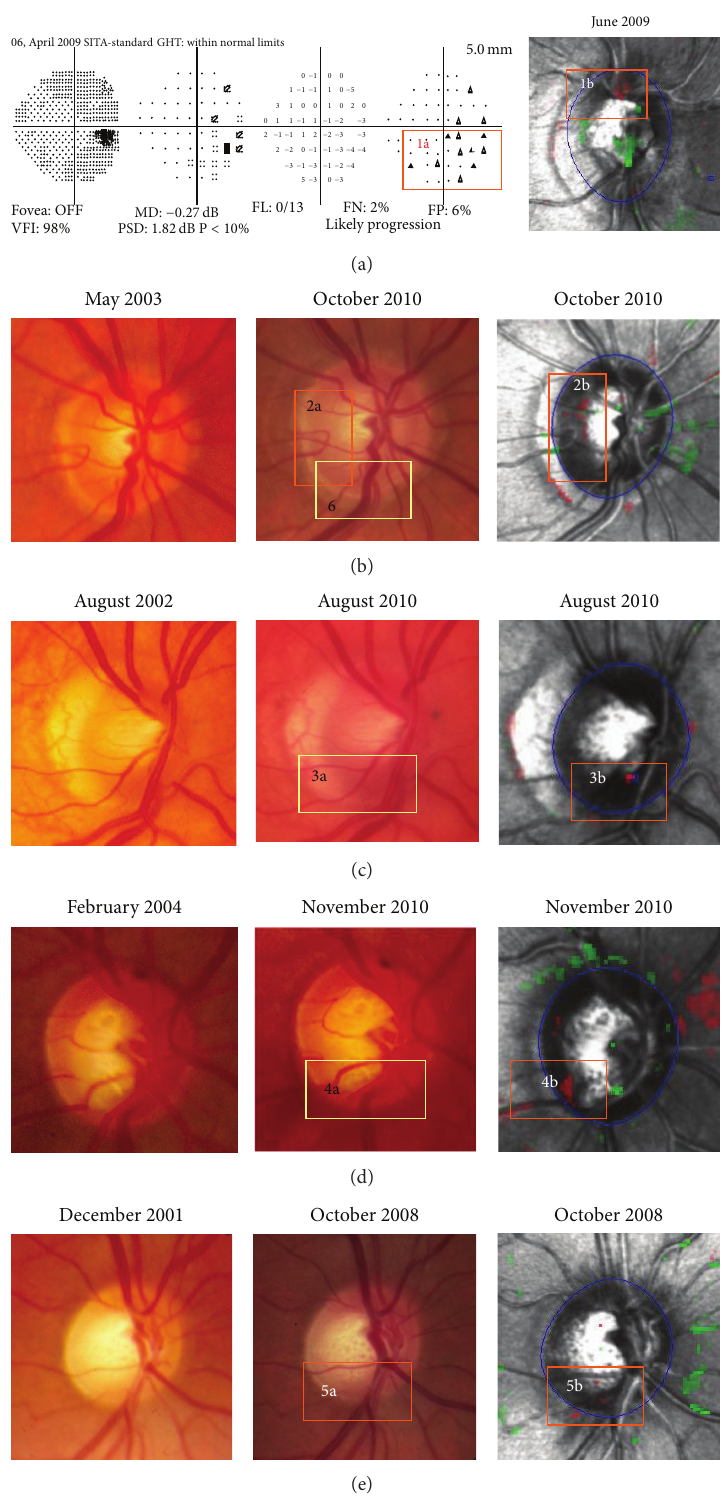
Figure 5: Five out of 13 TCA-stable cases showing clinical progression. In all cases the HRT highlighted the corresponding optic nerve head (ONH) area but with fewer than 20 superpixels. (a) Progression was found on inferior visual field (VF) hemifield (1a). The HRT highlighted thecorrespondingONHarea—overthevessels(1b).(b)Progressionwasfoundonstereophotograph(SPG)(temporal(2a)andinferior(6)rim thinning). TCA highlighted the temporal ONH area only (2b). (c), (d) and (e) Clinical progression in 3a, 4a, and 5a disc areas was highlighted by TCA (3b, 4b, and 5b,